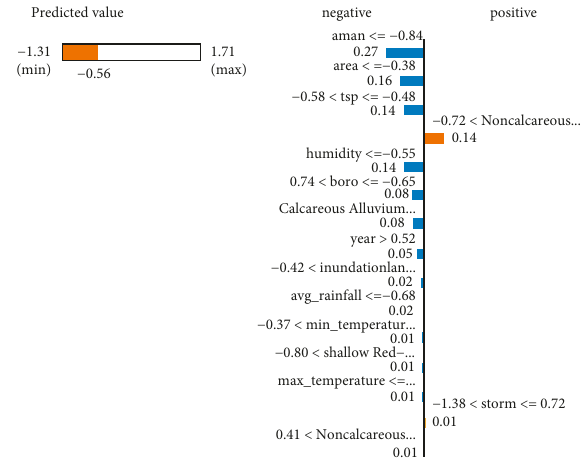
Figure 14: A plot of LIME model values for the SVR model and Aus yield